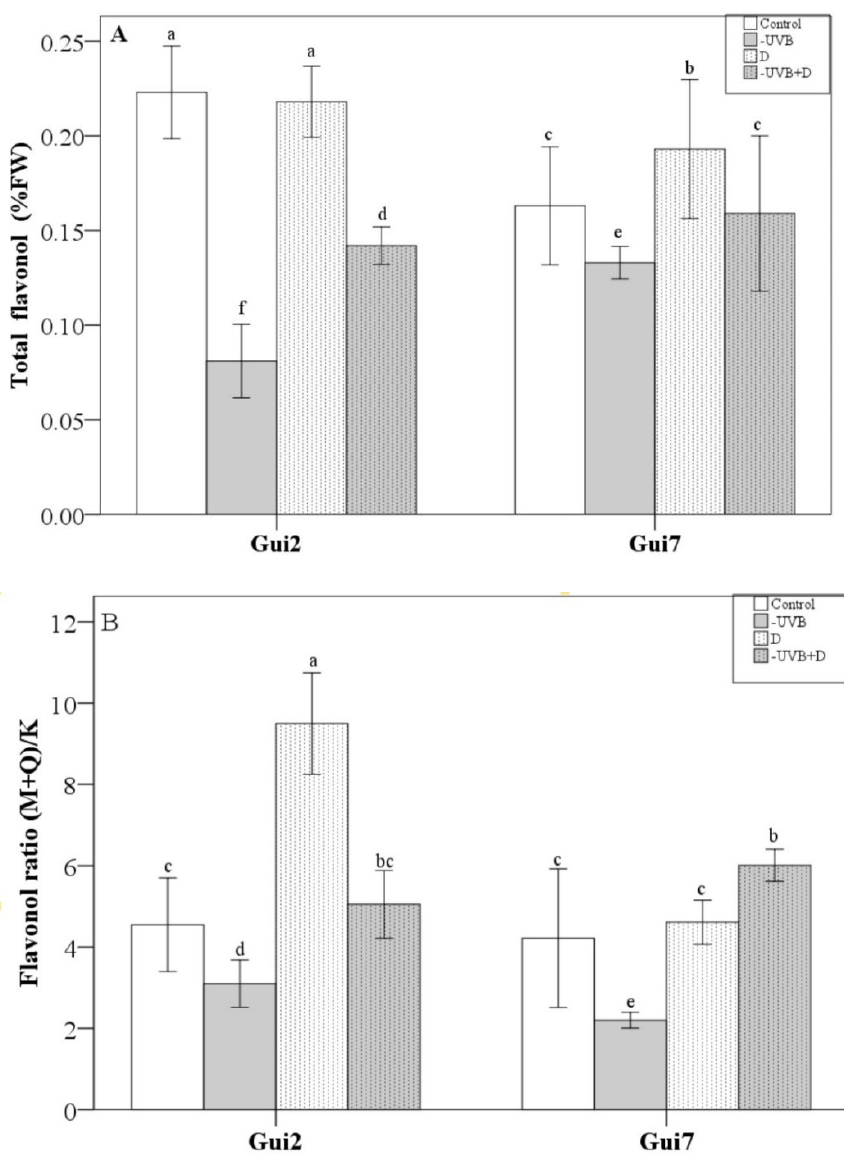
Figure 3. Concentration of leaf total flavonol aglycones (Kaempferol+QuercetinMyricetin) measured after acid hydrolysis ( A ) and Flavonol ratio (M+Q)/K [(myricetin+quercetin) /kaempferol ratio] ( B ) of two Chestnut rose cultivars under different water regimes and solar UV-B treatments. Values are mean ± SD. Different letters above the bars indicate significant difference between treatments at p < 0.05 level by LSD pairwise comparisons. Control, ambient UV-B; –UV-B, UV-B exclusion; D, drought with ambient UV-B; –UV-B+D, drought with UV-B